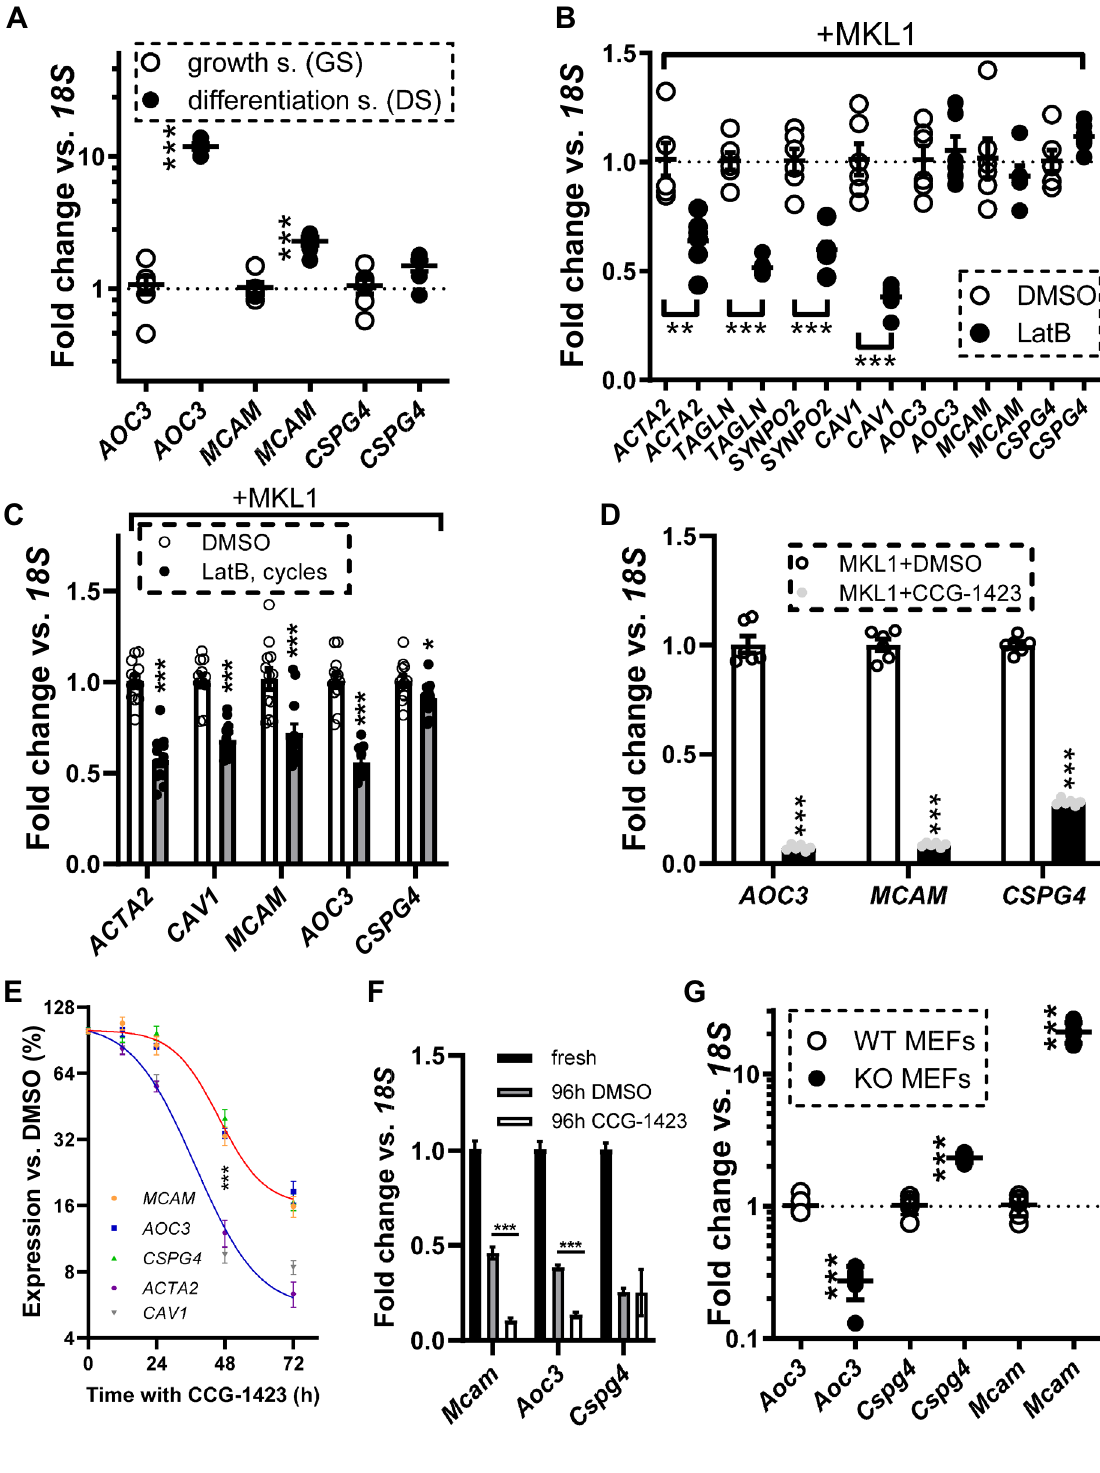
Figure 5. SMC differentiation, actin dynamics, and loss of Ternary Complex Factors (TCFs) all affect AOC3 , MCAM, and CSPG4 expression. In panel ( A ), human coronary artery smooth muscle cells were incubated with either growth supplement (GS) or differentiation supplement (DS) for 72 h and the mRNA levels of AOC3 , MCAM , and CSPG4 were determined by RT-qPCR (N = 6). In panels ( B ) and ( C ), the effects of Latrunculin B (LatB), which depolymerizes actin, were tested using two different protocols ( B 24 h static, and C 20 h with drug + 4 h washout in cycles for 96 h, N > 6). Transcript levels were assayed using RT-qPCR. All cells in ( B ) and ( C ) were transduced with MRTF-A/ MKL1 . Panel ( D ) (72 h treatment) and panel ( E ) (time-course) show effects of the MRTF-SRF inhibitor CCG-1423. Panel ( F ) compares transcript levels in freshly isolated mouse caudal arteries with mouse caudal arteries that were organ cultured in the presence of vehicle (DMSO) or CCG-1423 (96 h). In panel ( G ), the levels of Aoc3 , Mcam , and Cspg4 were determined by RT-qPCR in mouse embryonic fibroblasts (MEFs) from wild type (WT) mice, and in MEFs from mice that lack three Ternary Complex Factors (Elk1, Elk3, and Elk4). *P < 0.05, **P < 0.01, ***P < 0.001, versus the respective